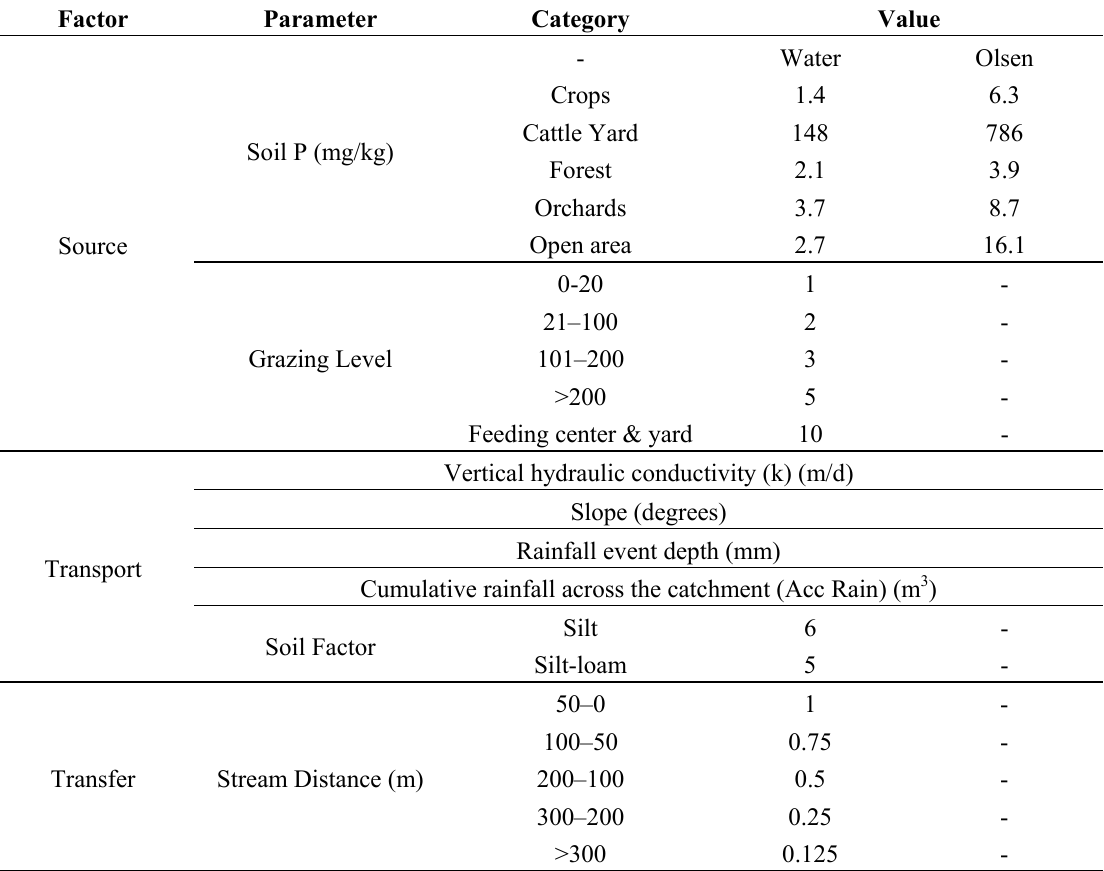
Table 3. Attributes used to compute the P index with Hermon Model. The soil-P represents average values in mg/kg.